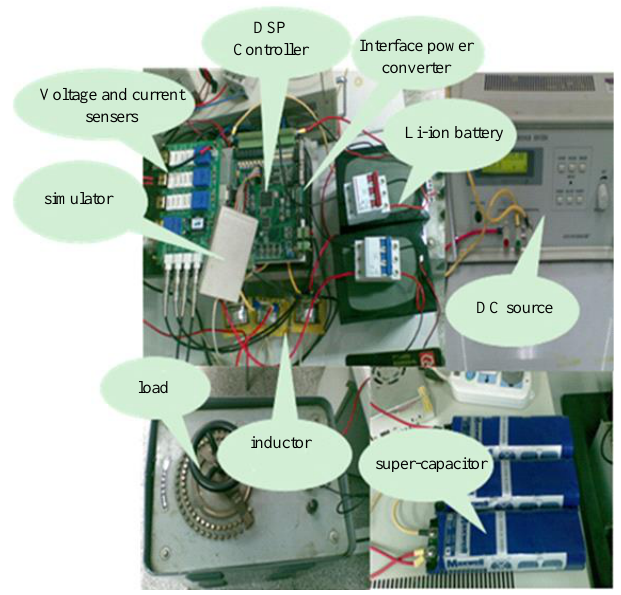
Figure 12. Experimental setup of the composite energy storage system. Table 1. Parameters of experimental platform.